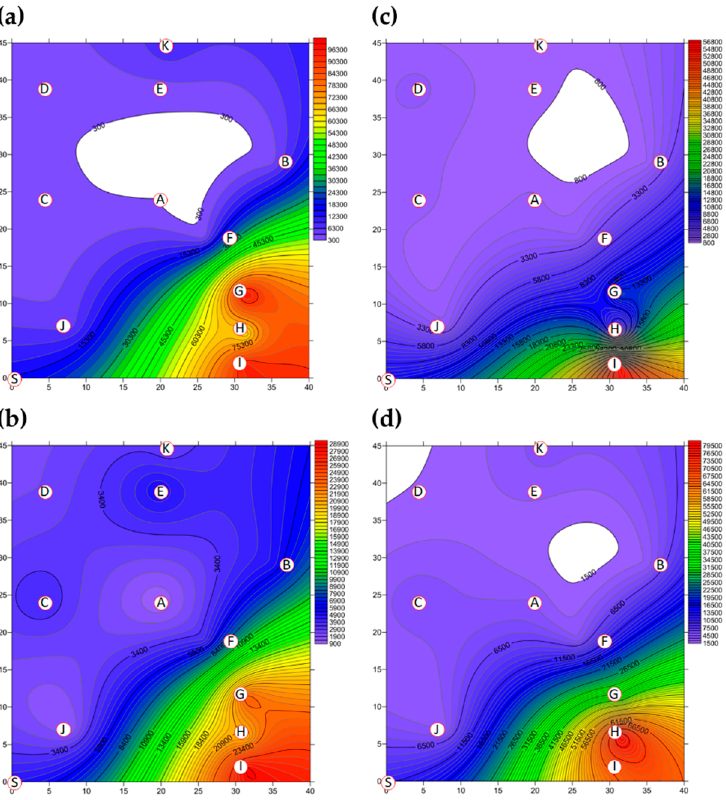
Figure 2. The total bacterial bioaerosol (BB) concentration (CFU m − 3 ) present in Market A ( a ) before operations commenced and ( b ) present after operations had finished; the total fungal bioaerosol (FB) concentration (CFU m − 3 ) in Market A ( c ) before operations commenced and ( d ) present after operations had finished. Red circular dots with English titles represent the sampling locations. Bioaerosol levels in the areas marked in white were below the cutoff values.